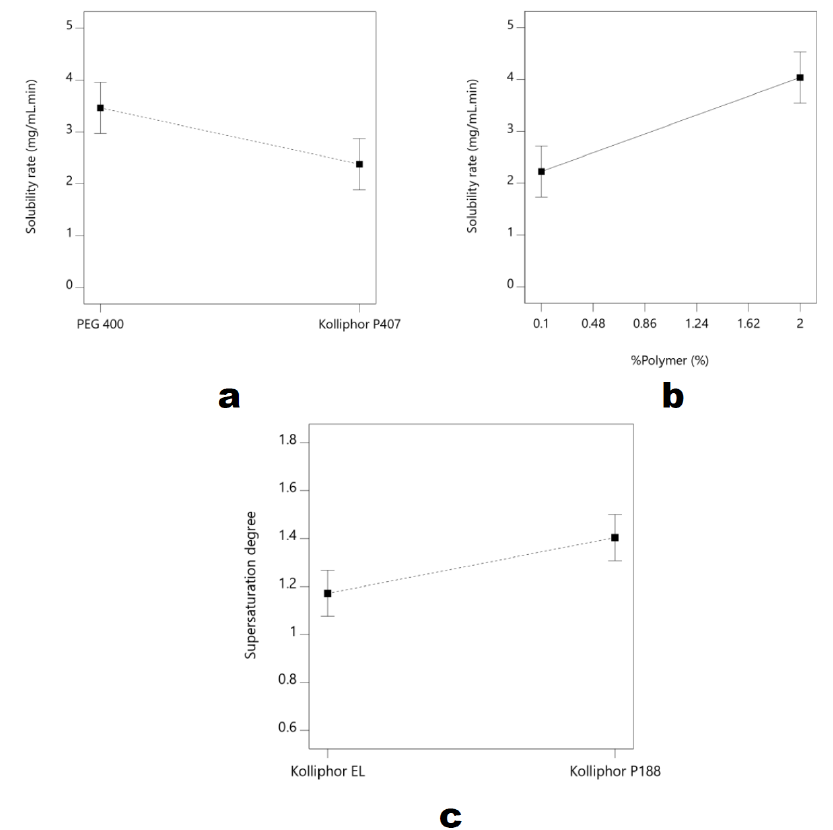
Figure 6. Single plots of solubility rate at polymer type ( a ) and concentration ( b ), and supersaturation degree at surfactant type ( c ).